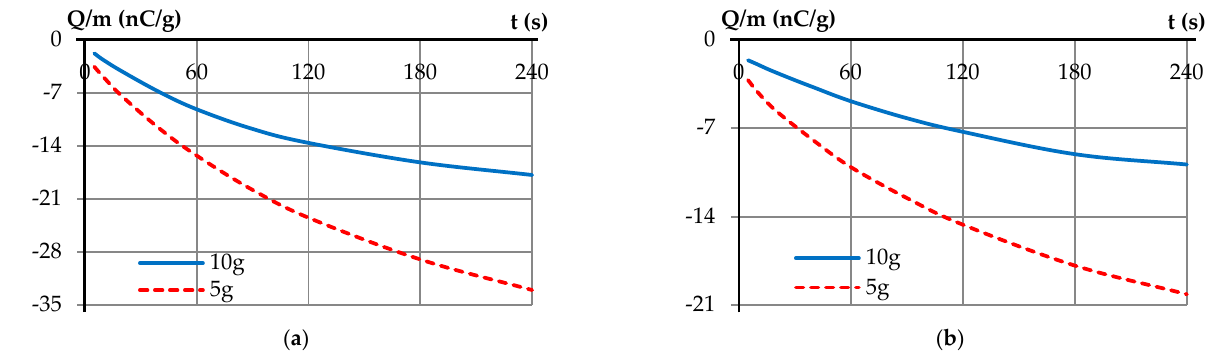
Figure 10. Charge density per mass as a function of time t of tribocharging in a container for PET with fractions ( a ) 1.8–2.8 mm and ( b ) 2.8–4 mm at airflow V = 1.6 cpm.